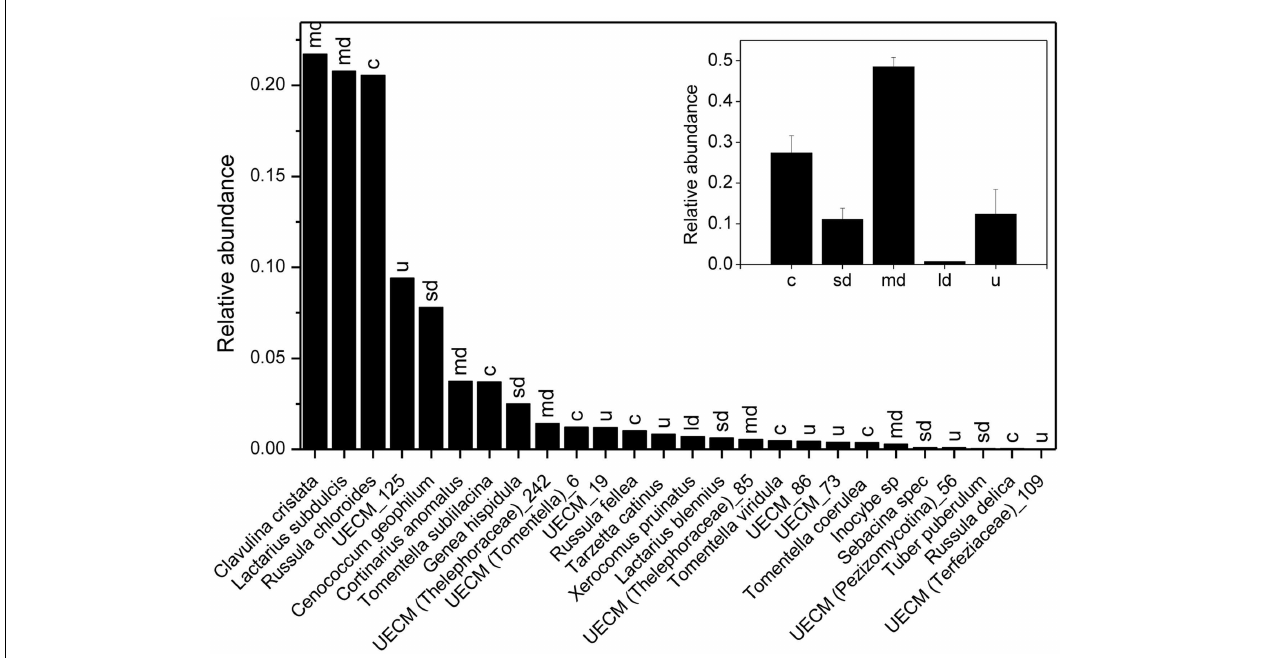
c = contact, sd = short distance, md = medium distance, ld = long distance, u = unknown.The inset shows the relative contribution of different EcM exploration types to root tip